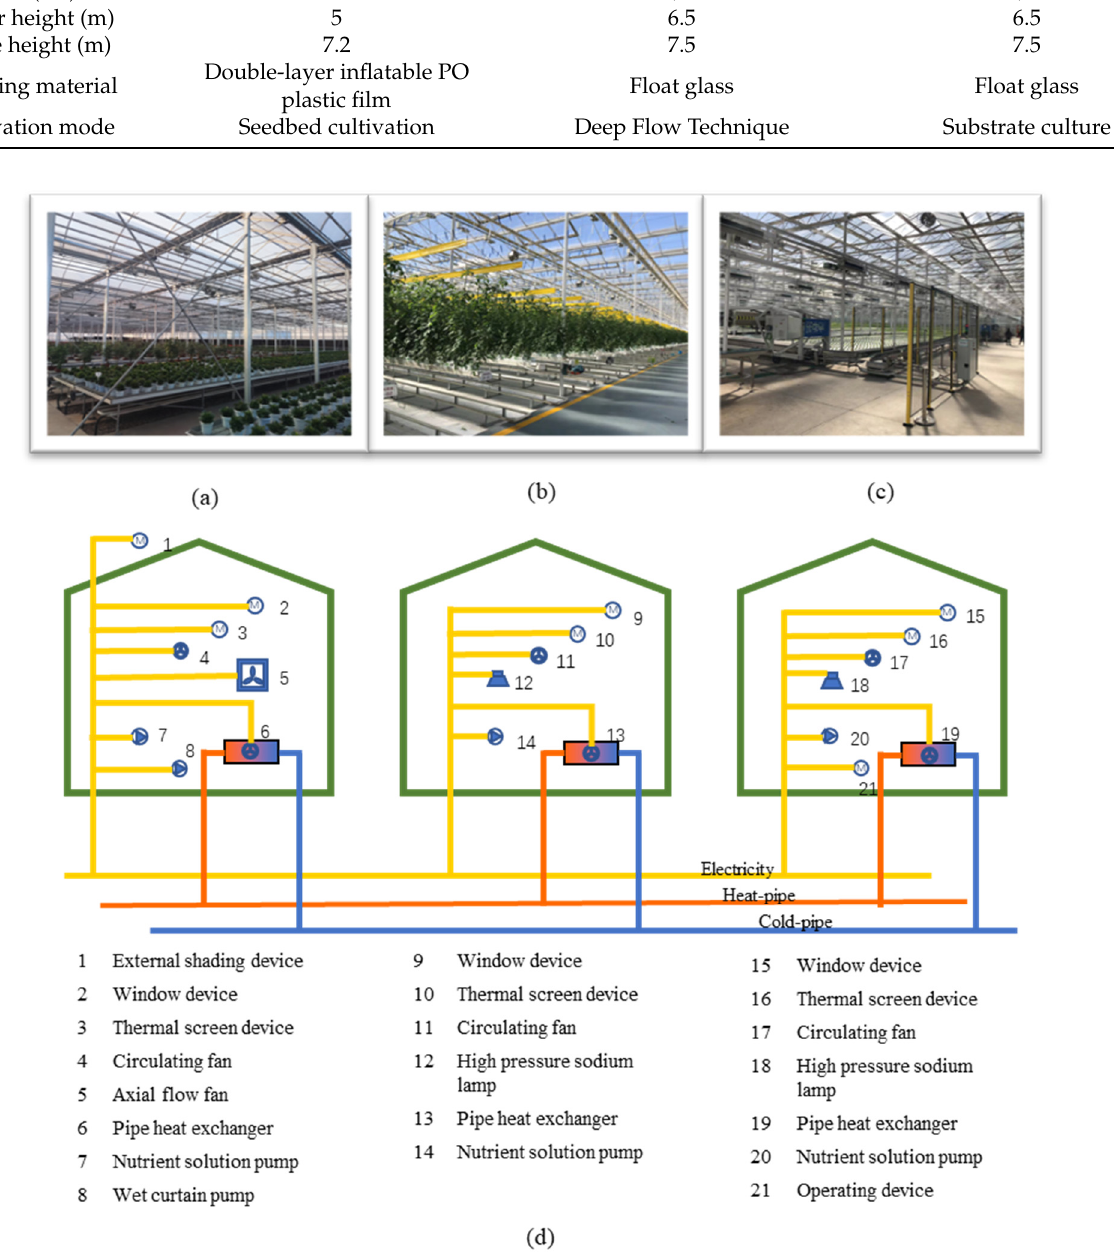
Figure 5. The three greenhouses, the heat–cold system, and the electric equipment. ( a ) Flower greenhouse. ( b ) Tomato greenhouse. ( c ) Lettuce greenhouse. ( d ) From left to right are the energy- consuming equipment of flower, lettuce, and tomato greenhouses. consuming equipment of flower, lettuce, and tomato